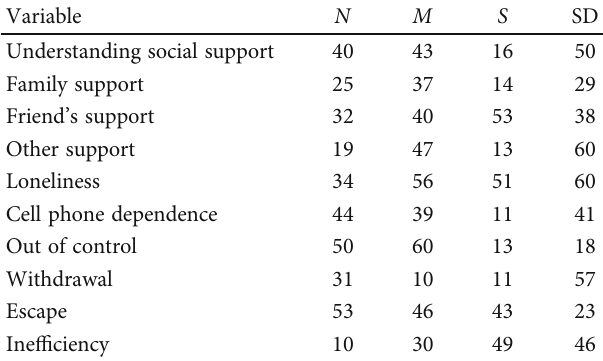
Table 1: Descriptive